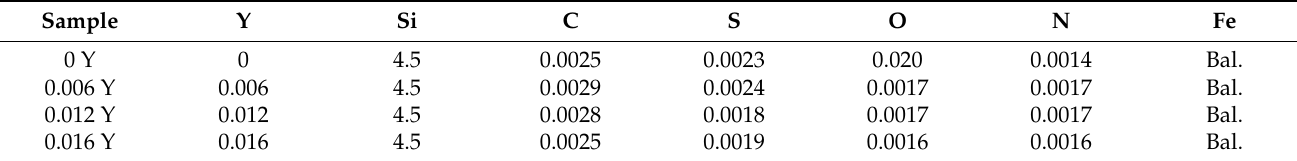
Table 1. The chemical composition of the ingots